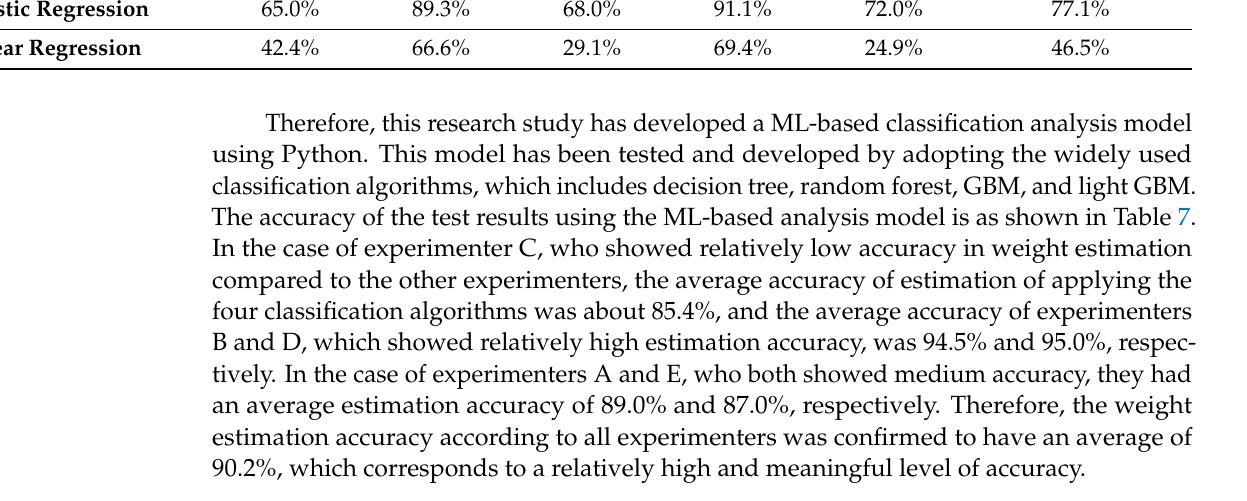
Table 6. The average of weight classification accuracy by using logistic and linear regression classifiers. Classification Algorithms